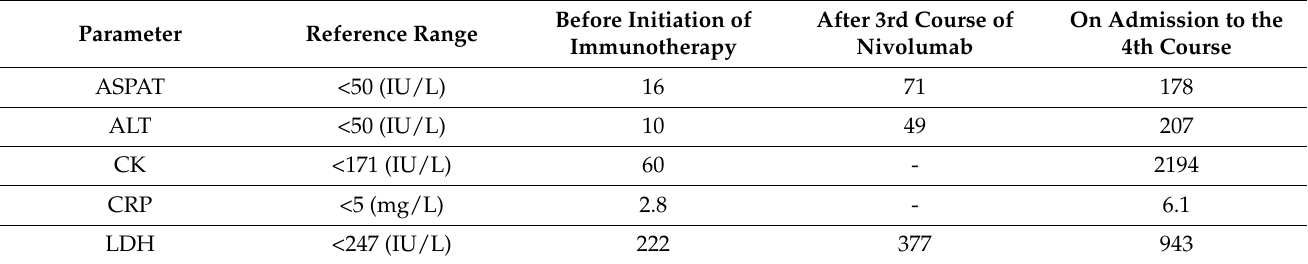
Table 1. Changes in selected laboratory parameters during immunotherapy. ALT-alanine transam- inase, ASPAT-aspartate transaminase, CK-creatine kinase, CRP-C-reactive protein, LDH-lactate